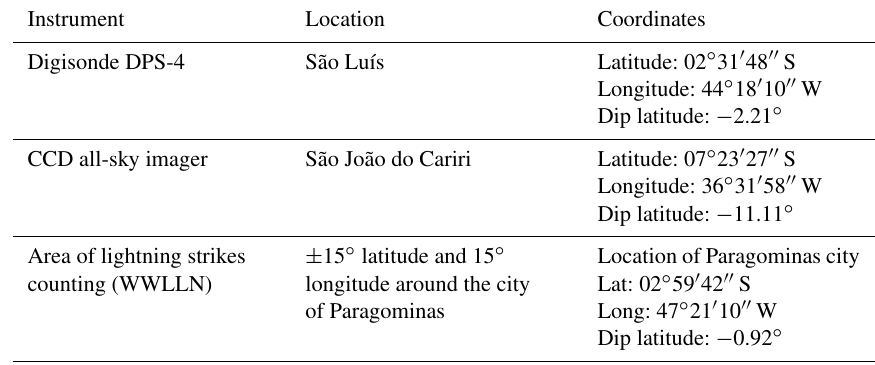
Table 1. Location of all the different instruments used in this